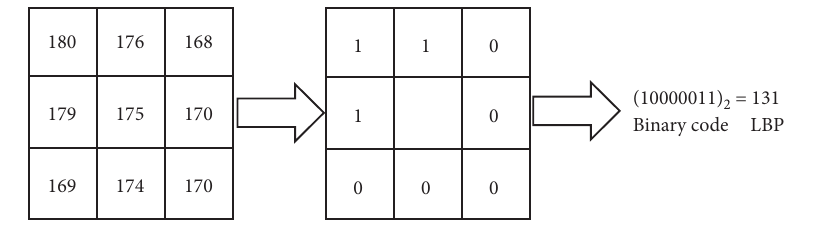
Figure 2: Computation of the LBP code of a given pixel (175).